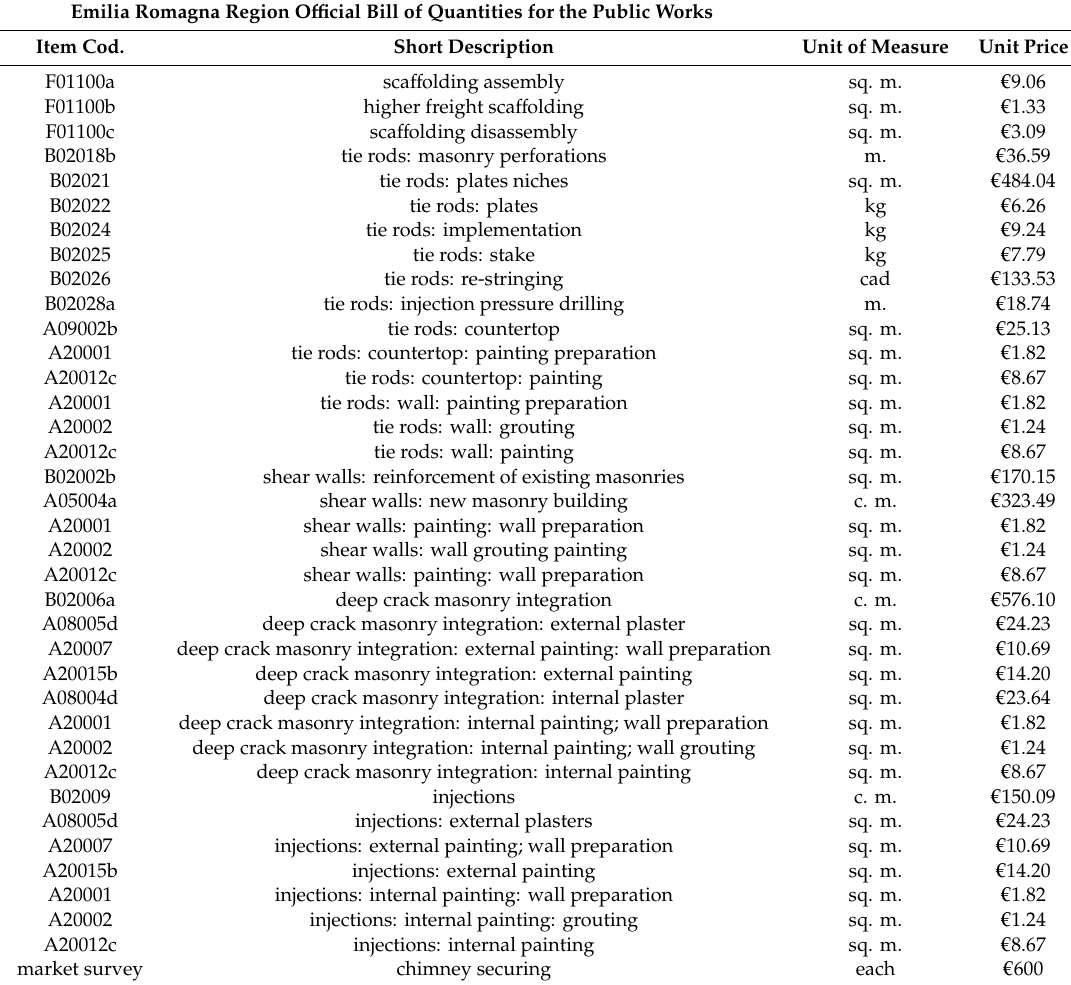
Table 2. List of the proposed vulnerability of reduction works based on the vulnerability degree and the Architectural Unit